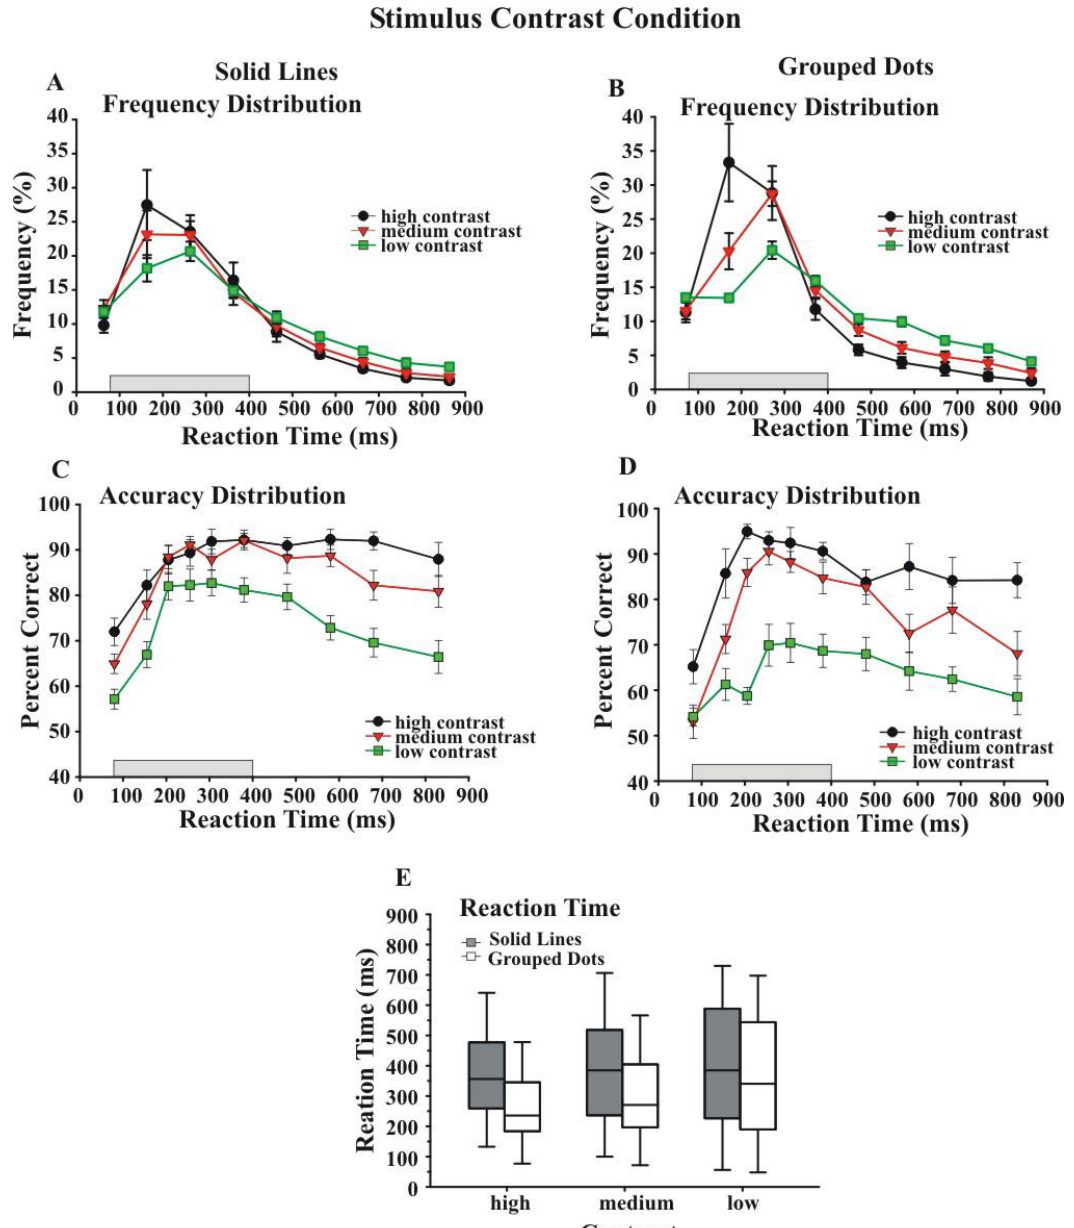
Figure 2 . Performance with solid-line and grouped-dot stimuli across levels of stimulus contrast. RT are relative to stimulus onset. Each data point for A-D is based upon 10 (for solid lines) or 8 rats (for grouped dots), each of which was collected across approximately 175 trials. A and B : Response frequency distributions; C and D : Percent correct for pattern discrimination across bins of RT. Error bars represent SEM. Shaded region depicts period during which reward could be delivered during training. E : Reaction time across contrast for solid-line and grouped-dot stimuli. Center lines depict median, box borders depict 25 th and 75 th percentiles, error bars depict 10 th and 90 th